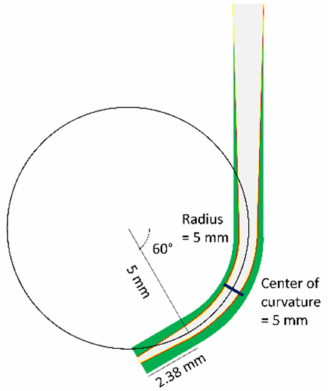
Figure 1. Technical drawing of the artificial root canals with the illustration of superimposed artificial root canals; gray = instrument size +0.02 mm, yellow = +0.05 mm, red = +1.0 mm, green = parallel tube 1.25